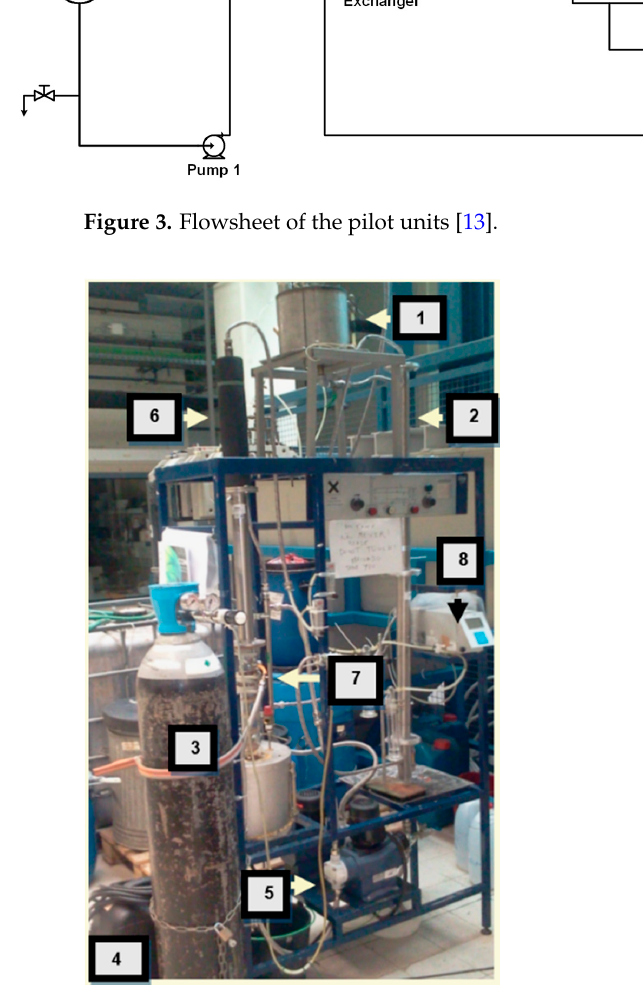
Figure 4. Small pilot unit [13] and its components: 1 —Feeding tank; 2 —Absorption column; 3 —CO 2 cylinder; 4 —Air compressor; 5 —Dosing pump; 6 —Stripping column; 7 —Heat exchanger; 8 —CO 2 analyzer.